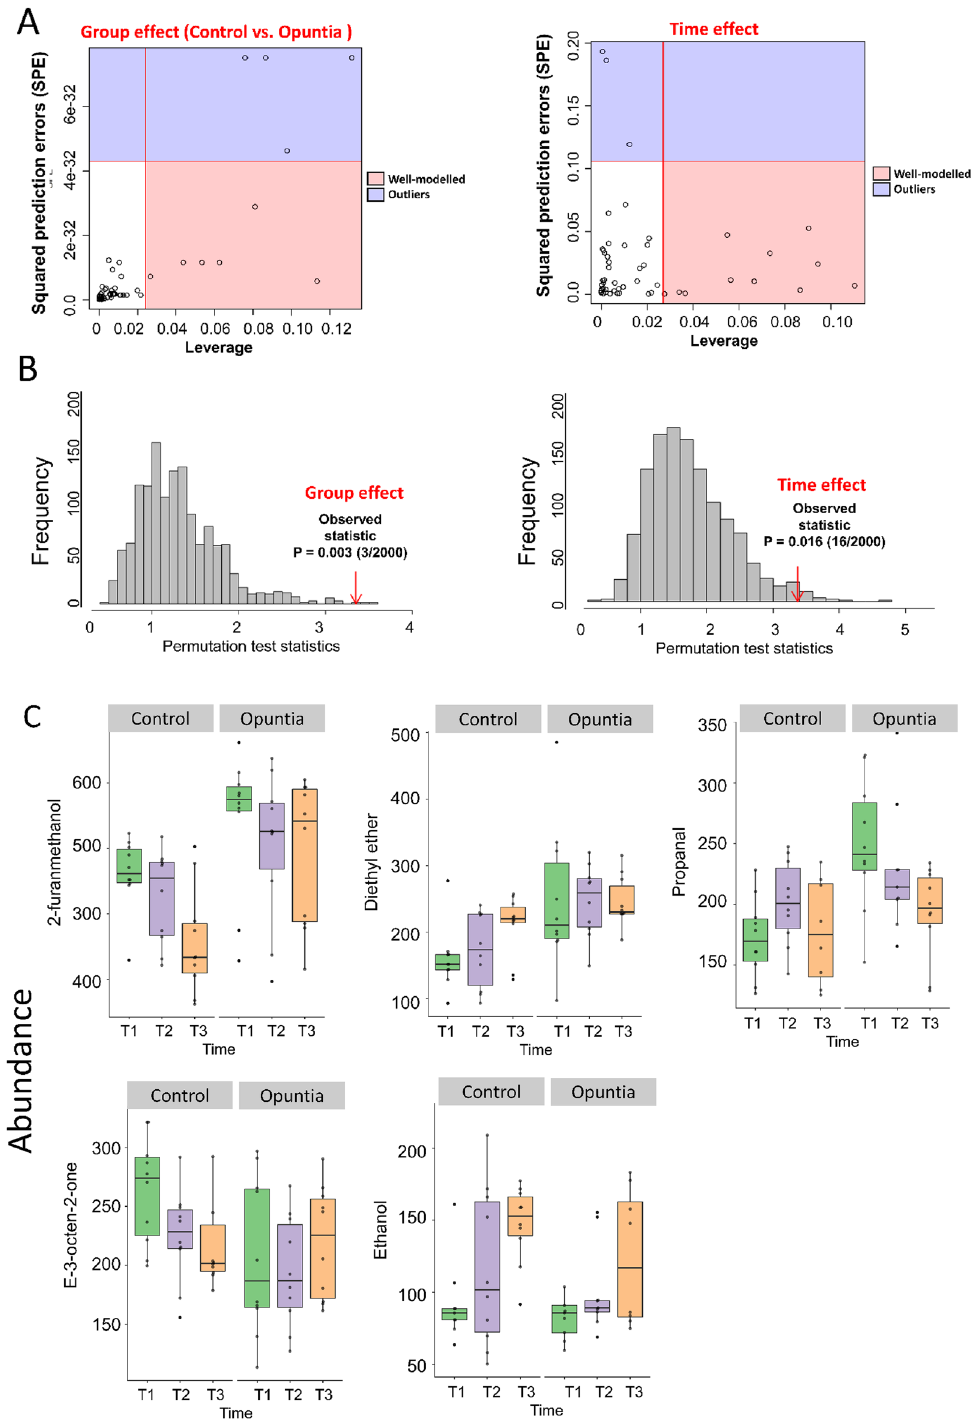
Figure 5. ( A ) Leverage and squared prediction error (SPE) scatter plots of the ANOVA-simultaneous component analysis (ASCA) variables sub-models for Control and Opuntia sheep, and time. Vertical and horizontal lines indicate cut-off leverage and SPE values, respectively. The leverage evaluates the importance of the metabolite to the model, and SPE tests the fitness of the model for particular metabolites. Metabolites with a high leverage value and a low SPE value were considered to be differential metabolites (the well- modelled group). Metabolites in blue have patterns that are different from the major patterns. Metabolites in the white area have patterns that are similar to the major patterns. ( B ) The results of model validations through permutations. ( C ) Abundance of metabolites in the leverage–SPE scatter plots of the ASCA variables submodels for group (Control vs. Opuntia) and time. T1, T2 and T3 correspond to days 0, 30, and 45, respectively. Metabolomics data analysis was performed using the free web-based metabolomics tool (MetaboAnalyst 4.0; https:// www. metab oanal yst. ca/ home. xhtml) 54